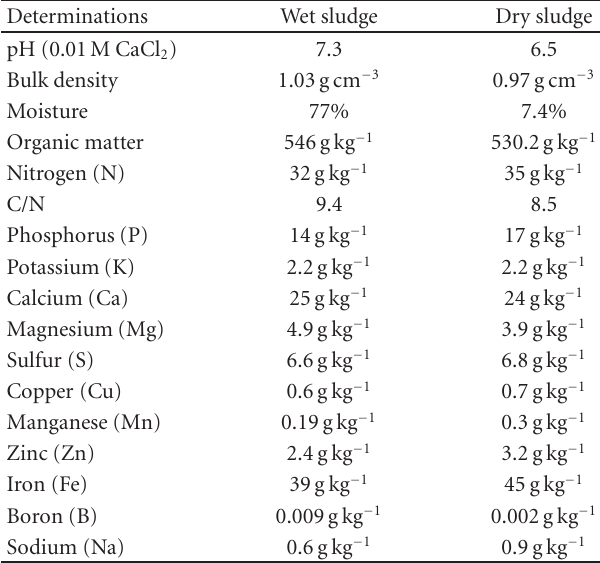
Table 2: Chemical analysis of wet and dry sewage sludge applied in the